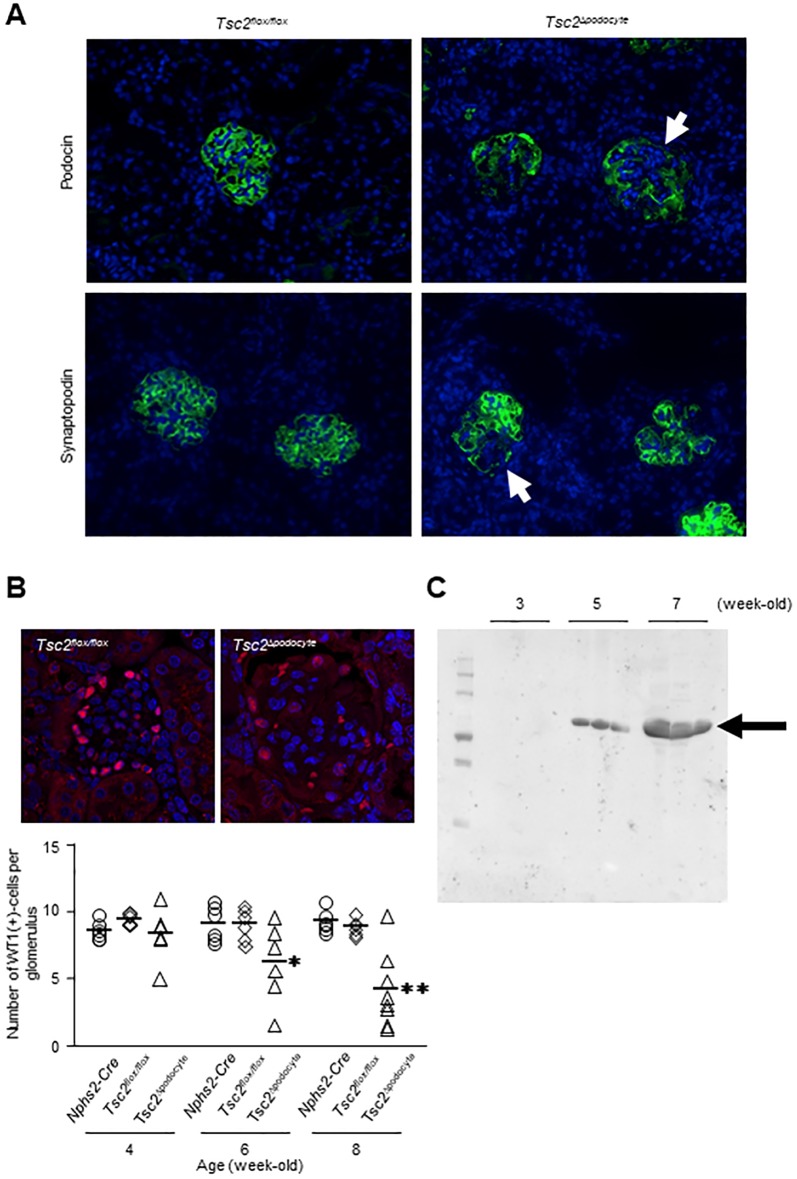
Podocytes in Tsc2Δpodocyte mice were excreted in urine from glomeruli with progression of renal functional decline.(A) Immunofluorescence staining of podocin and synaptopodin showed decreased signal intensity in Tsc2Δpodocyte mice (arrows). (B, top) The number of podocytes was decreased in the glomeruli of Tsc2Δpodocyte mice. Representative images of WT1 positive (red) and Hoechst 33342-positive (blue) podocytes are shown. (B, bottom) The graph shows the average number of podocytes per glomerulus in each group. Each dot represents the mean number of WT1-positive cells in about 20 glomeruli from the indicated mouse, and horizontal lines represent the mean number of WT1-positive cells in each group. Tsc2Δpodocyte mice had fewer WT1-positive podocytes per glomerulus compared with age-matched controls. *P < 0.05, **P < 0.01 compared with age-matched controls. (C) Western blot analysis of abundance of WT1 in urine from Tsc2Δpodocyte mice. Loaded samples contained equal amounts of creatinine. WT1 gives a band at 52 kDa (arrow).